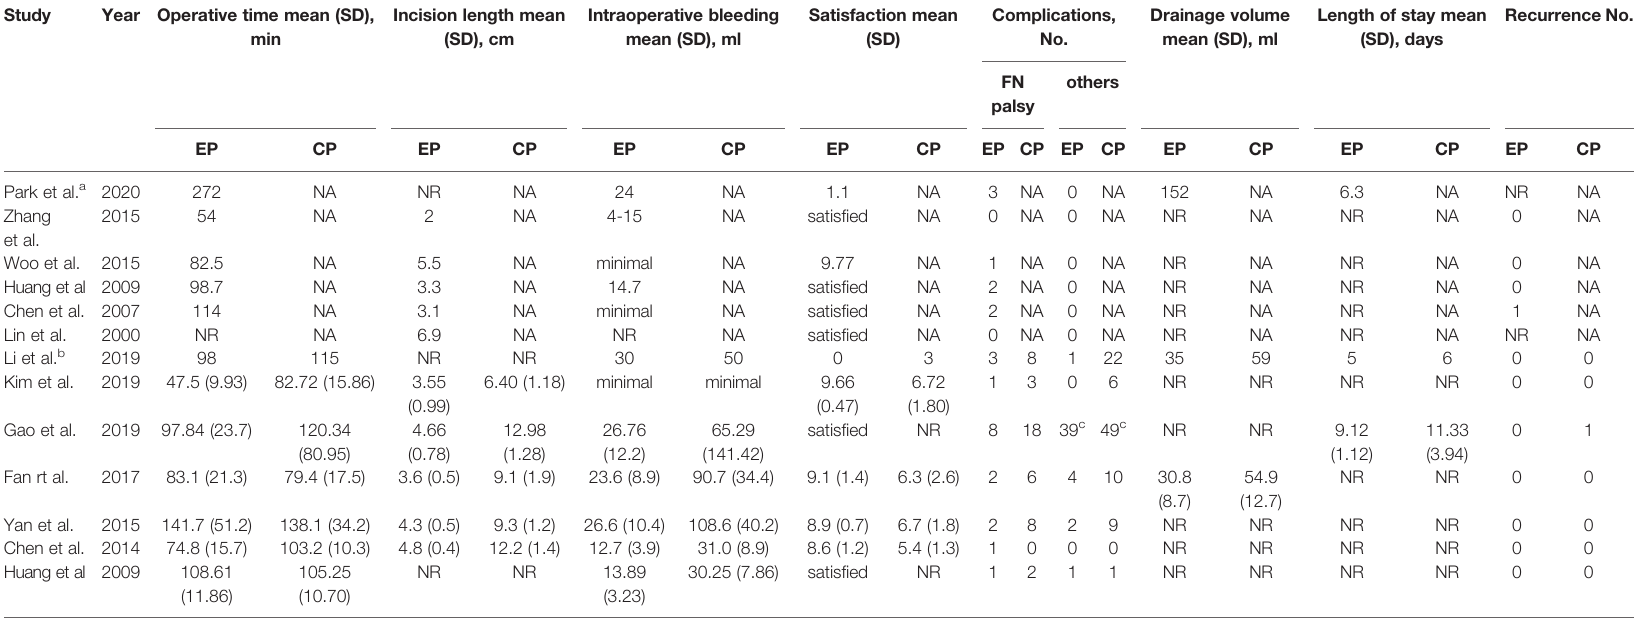
EP, endoscopic-assisted parotidectomy; CP, conventional parotidectomy; NR, not reported; NA, not available; FN, facial nerve. a Exclude data of one patient with thyroidectomy. b Continuous variables were expressed in median. c Original data were not considered